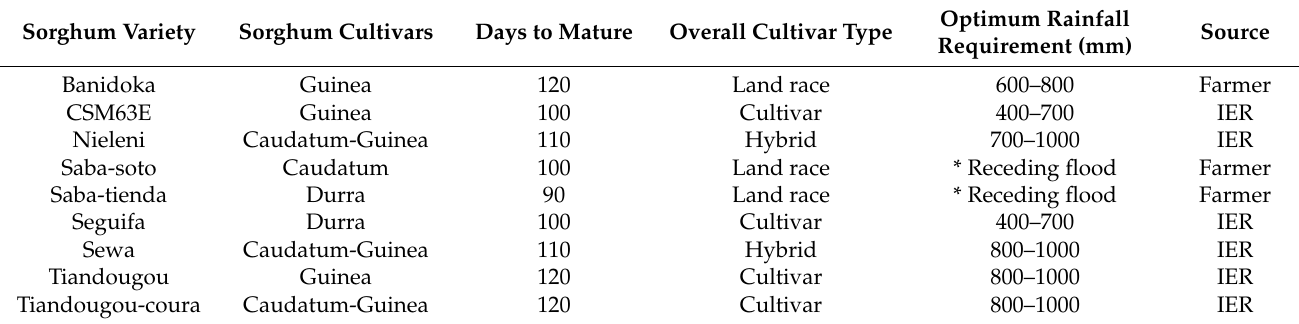
Table 1. Characteristics of the selected sorghum cultivars used during the screening experiments. Sorghum Variety